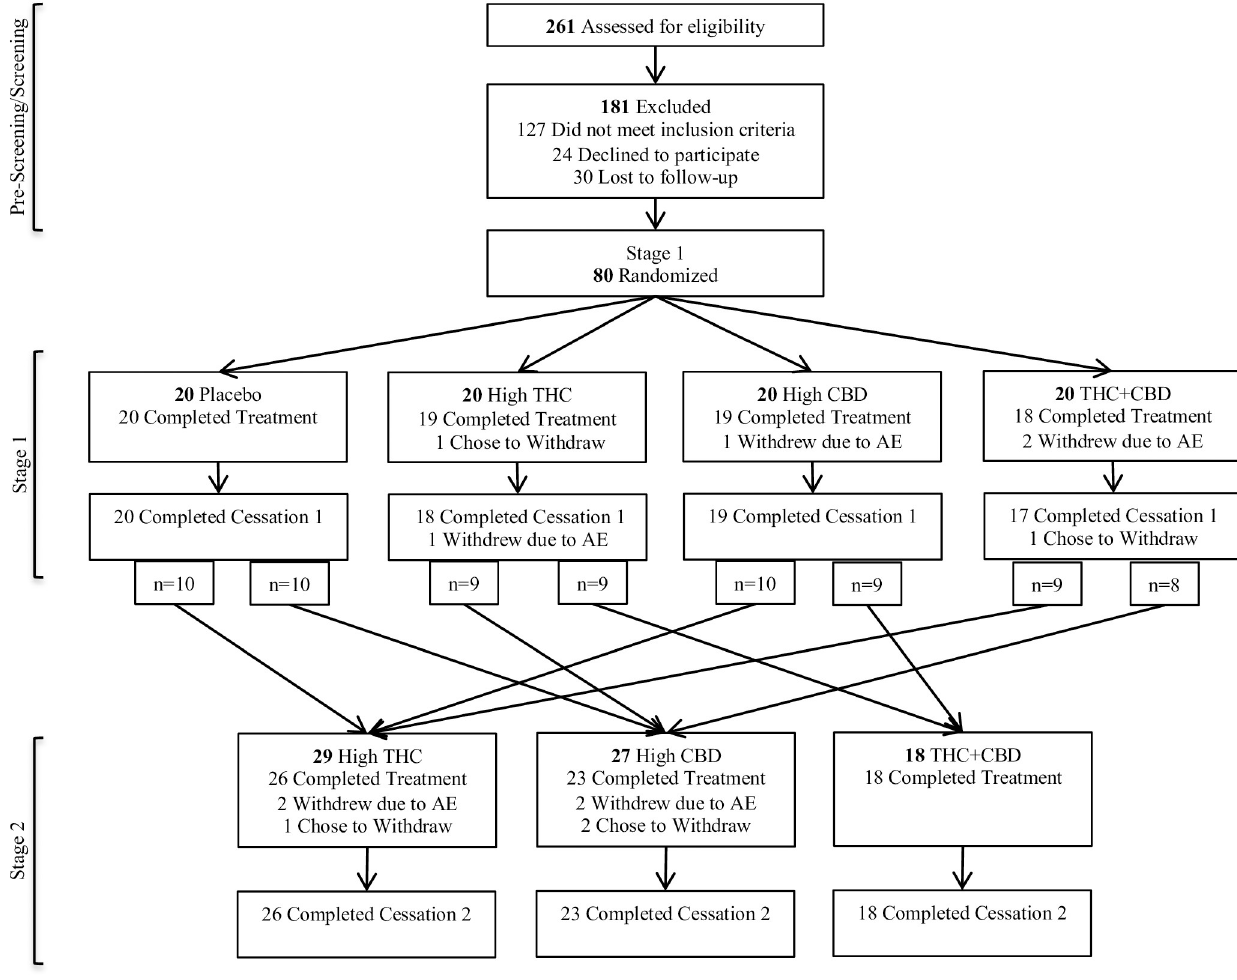
Fig 1. Consort flow